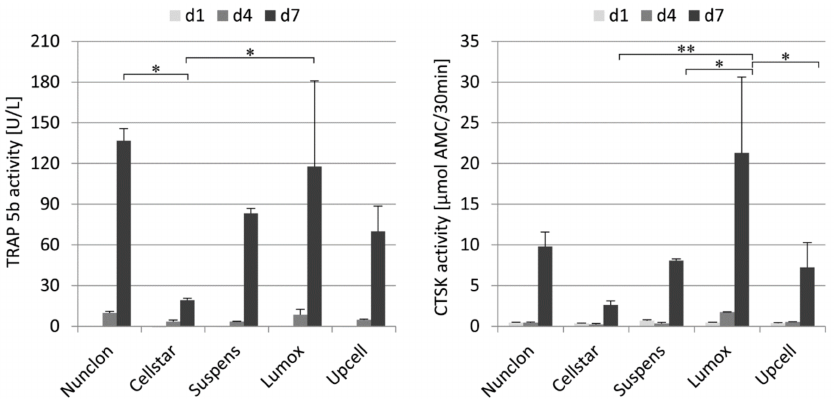
Figure 2. Extracellular TRAP 5b activity (left) and extracellular CTSK activity (right) of monocyte- derived osteoclasts during 7 days of cultivation on different cultivation substrates, * indicate p < 0.05, ** indicate p < 0.01.